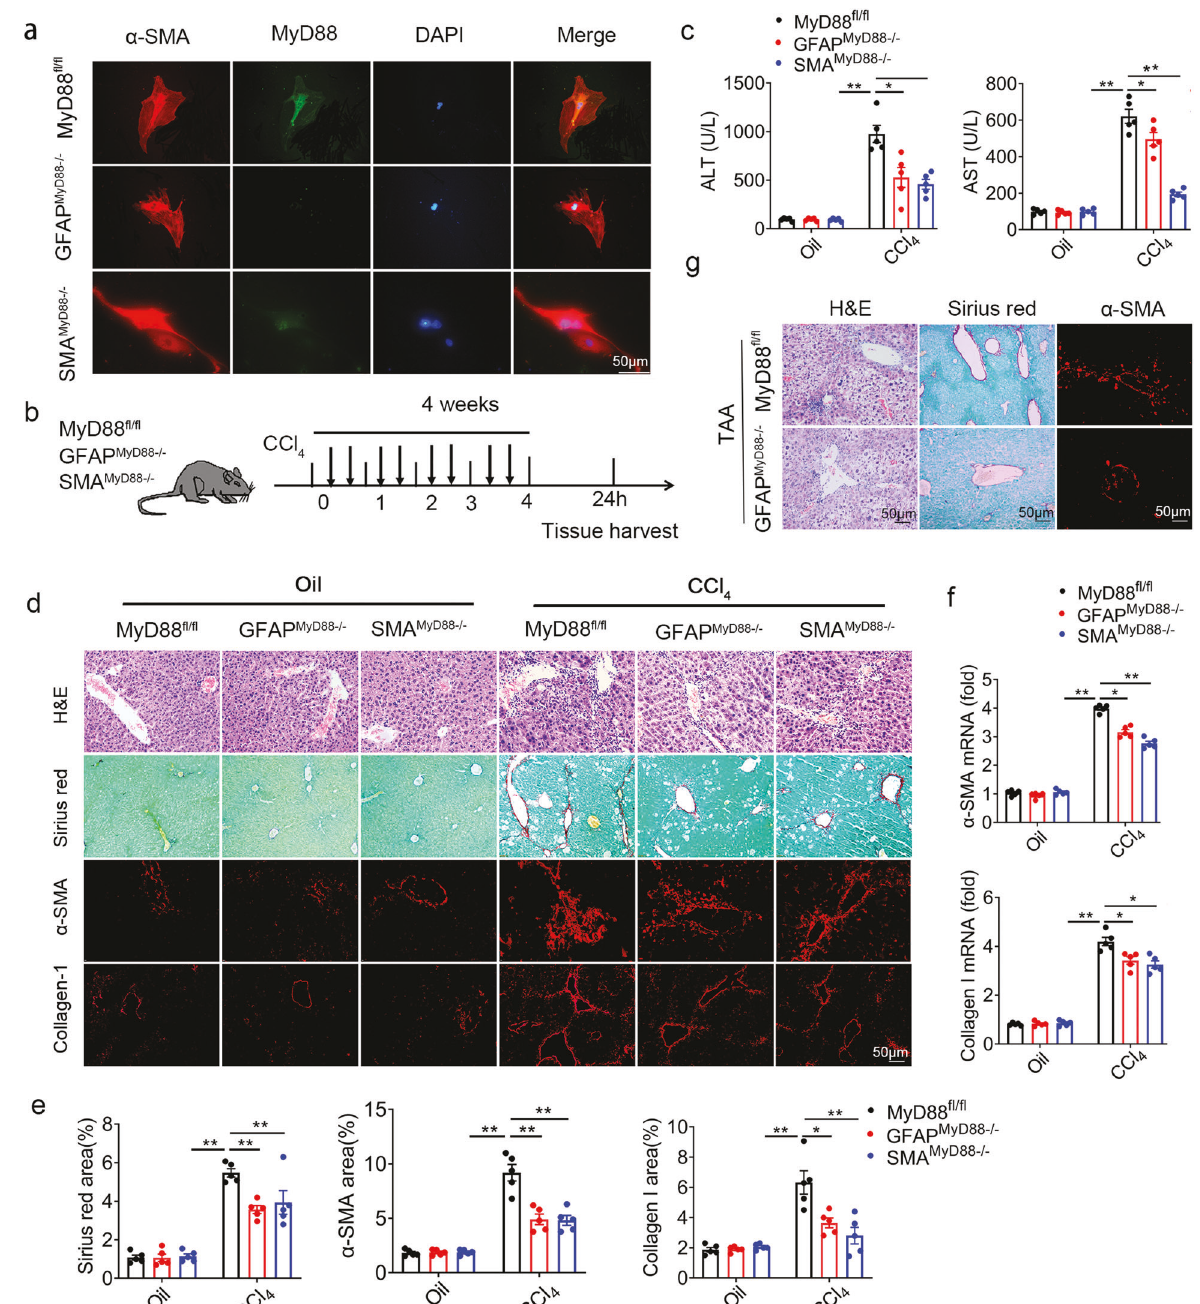
Fig. 2 MyD88 de fi ciency in HSCs attenuates CCl 4 -induced liver fi brosis. a HSCs were isolated from the liver of mice in the MyD88 fl / fl group and the GFAP MyD88 − / − , SMA MyD88 − / − groups, respectively, and were induced into myo fi broblasts after 7 days of culture for α -SMA (red) and MyD88 (green) double immuno fl uorescence staining. Scale bar, 50 μ m. Data were representatives of at least three independent experiments. b Groups of MyD88 fl / fl , GFAP MyD88 − / − , SMA MyD88 − / − mice ( n = 5 per group) were subjected to the CCl 4 -induced liver fi brosis. Data were representatives of at least three independent experiments. c Serum ALT and AST levels. * p < 0.05 and ** p < 0.01. d Representative staining of H&E, Sirius red, collagen I and α -SMA (Scale bar, 50 μ m) in liver tissues. e Statistical analysis of the Sirius red, collagen I and α -SMA staining in liver tissues. * p < 0.05 and ** p < 0.01. f mRNA levels of α -SMA and collagen I in liver tissues. * p < 0.05 and ** p < 0.01. g Groups of MyD88 fl / fl and GFAP MyD88 − / − mice ( n = 5 per group) were subjected to the TAA-induced liver fi brosis. Representative staining of H&E, Sirius red, and α -SMA (Scale bar, 50 μ m) in liver tissues. These charts show the average of the experimental results, with the error bar showing the standard error of mean. CXCL10 was highly expressed in α -SMA + cells in the fi brotic liver decreased most signi fi cantly in CCl 4 -treated GFAP MyD88 − / − mice compared with control mice (Fig. 5b, c). Decreased number of tissues (Fig. 5e), demonstrating that CXCL10 is expressed in aHSCs. CXCL10 + cells were also demonstrated by immuno fl uorescence Consistently, secretion level of CXCL10 protein was signi fi cantly increased in LX-2 cells induced by LPS/ConA, while the MyD88 double staining in MyD88 positive area of liver tissues (Fig. 5d). inhibitor ST2825 greatly suppressed COA and LPS-induced CXCL10 Further double immuno fl uorescence staining revealed that